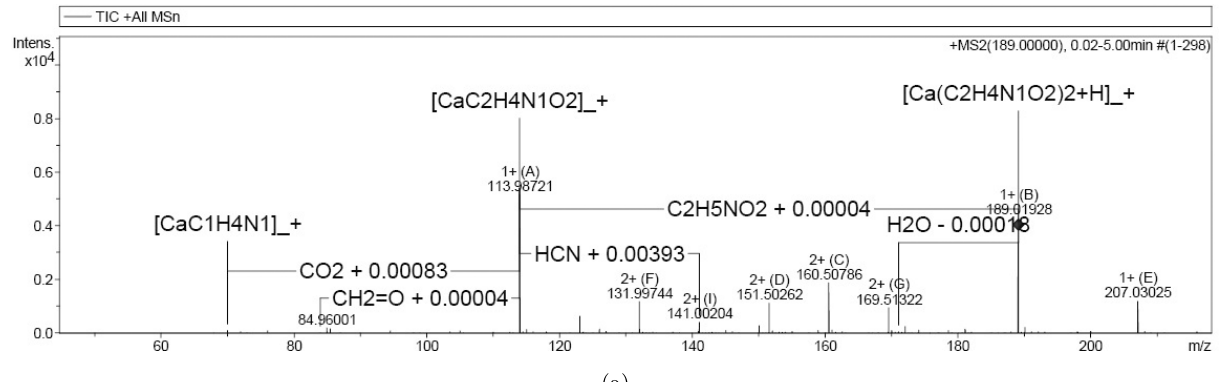
Fig. 3. The mass – mass spectra of calcium glycinate (a), the mass – mass spectra of magnesium glycinate (b), the mass – mass spectra of zinc glycinate